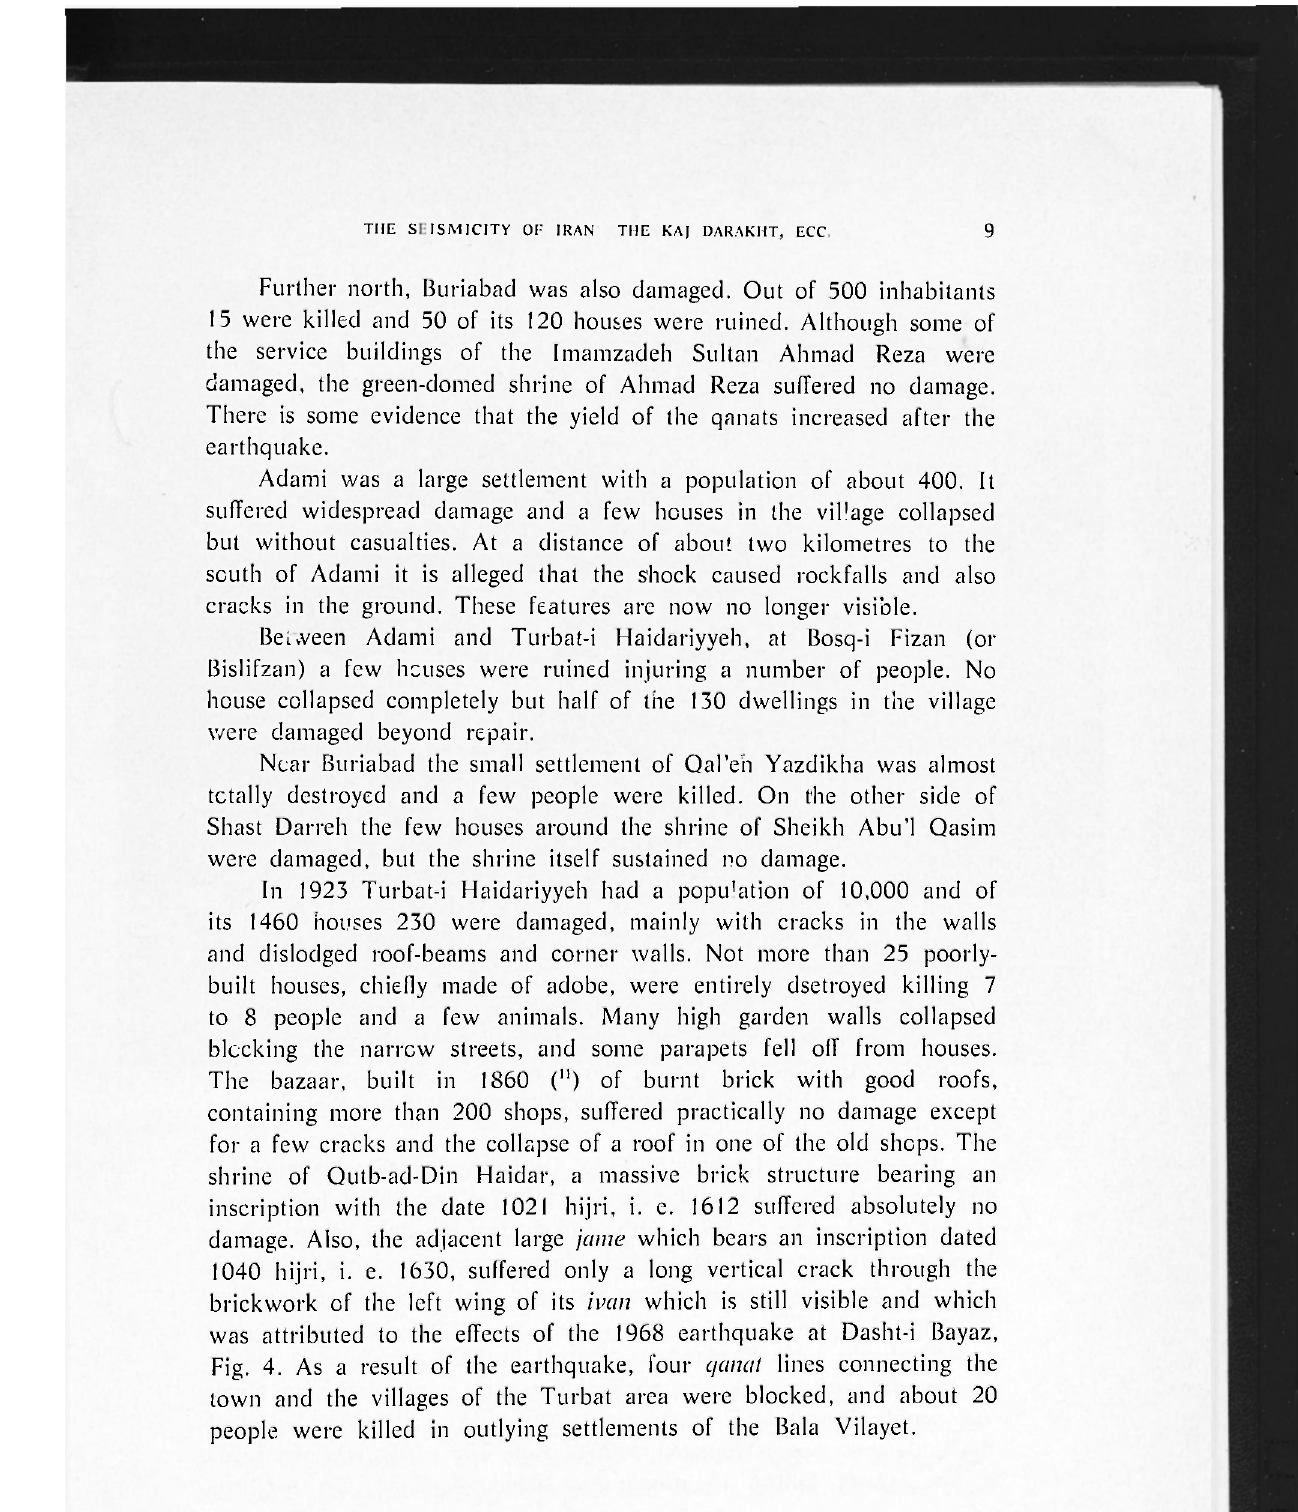
Fig. 4. As a result of the earthquake, four qanat lines connecting the town and the villages of the Turbat area were blocked, and about 20 people were killed in outlying settlements of the Bala